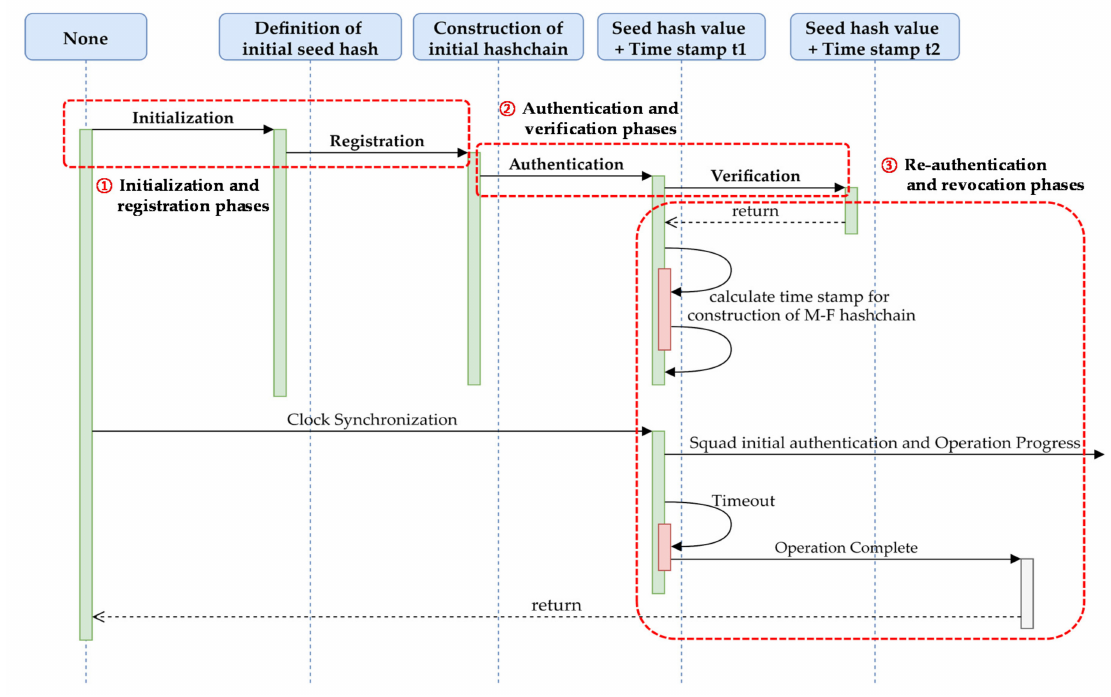
Figure 1. Proposed overall authentication scheme with multi-factor hash chain and T-OTP in VMF. The proposed processes included three specific phases: initialization and